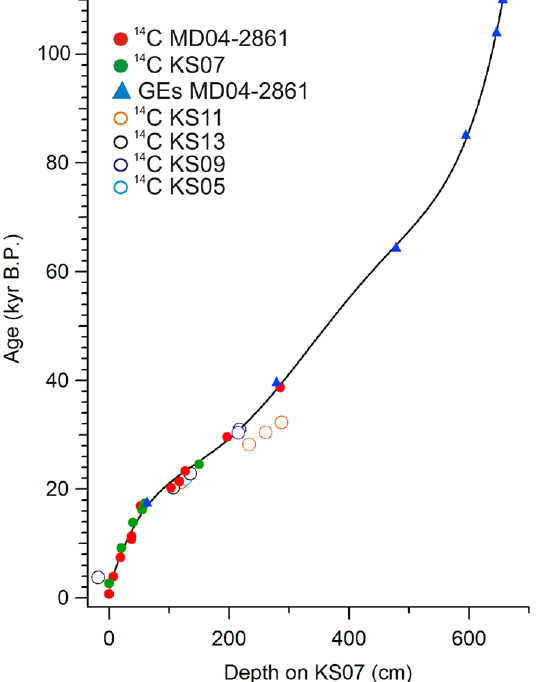
Fig. 2. Age model built with 17 radiocarbon ( 14 C) control points based on 2 different hemipelagic cores (MD04-2861 (Caley et al., 2011a) and KS07) and 6 Globorotalia event (GE) control points on core MD04-2861 (Caley et al., 2011a). Radiocarbon ( 14 C) control points for cores KS11, KS13, KS09 and KS05 are also indicated.